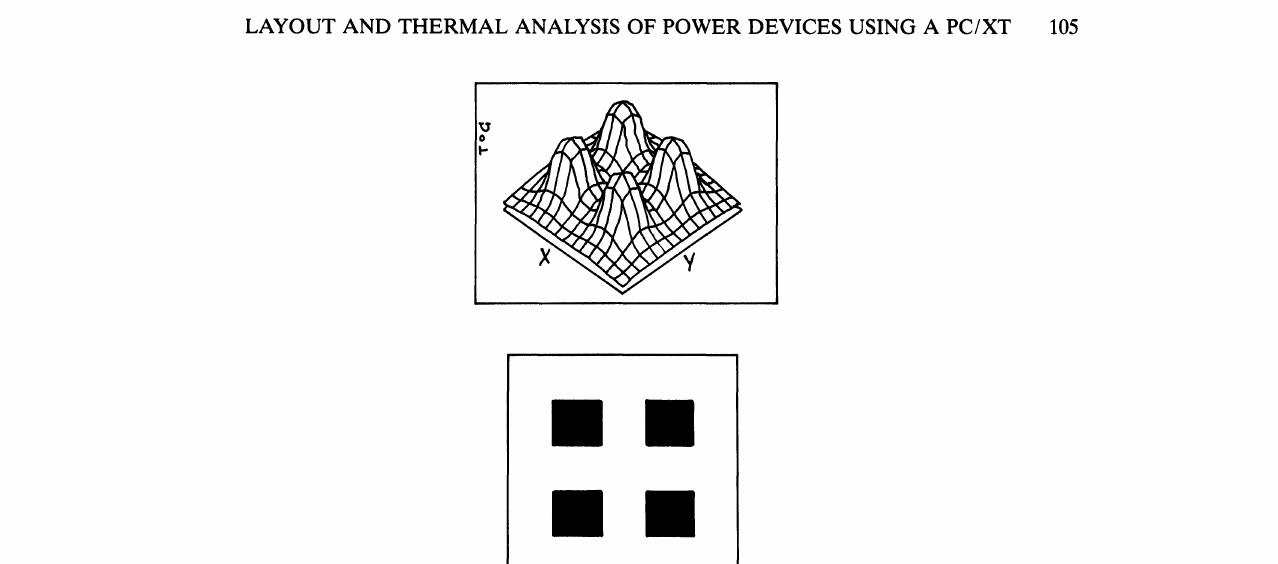
FIGURE 7 The 4 dice of Fig. 6 are 3mm; the temperature distribution on the upper surface of the ceramic substrate shows a maximum of